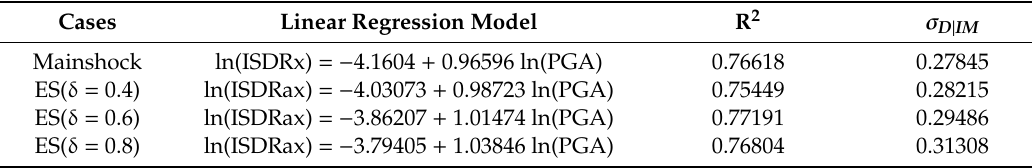
Table 5. Regression parameters for the